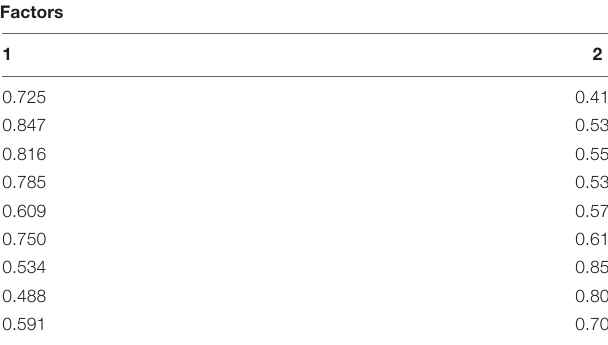
TABLE 3 | Pattern matrix of the adaptability